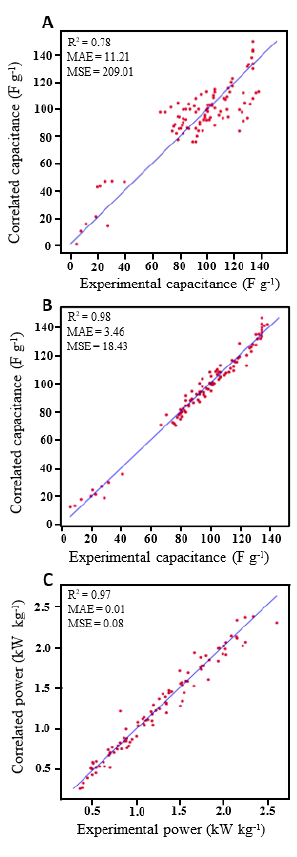
Figure 11. Comparison of correlation for the predicted specific capacitance (F g − 1 ) and the actual experimental specific capacitance (F g − 1 ) between the ( A ) MLP model with “6” inputs and ( B ) MLP model with more inputs; ( C ) correlated power (kW kg − 1 ), and the actual power density (kW kg − 1 ) of the